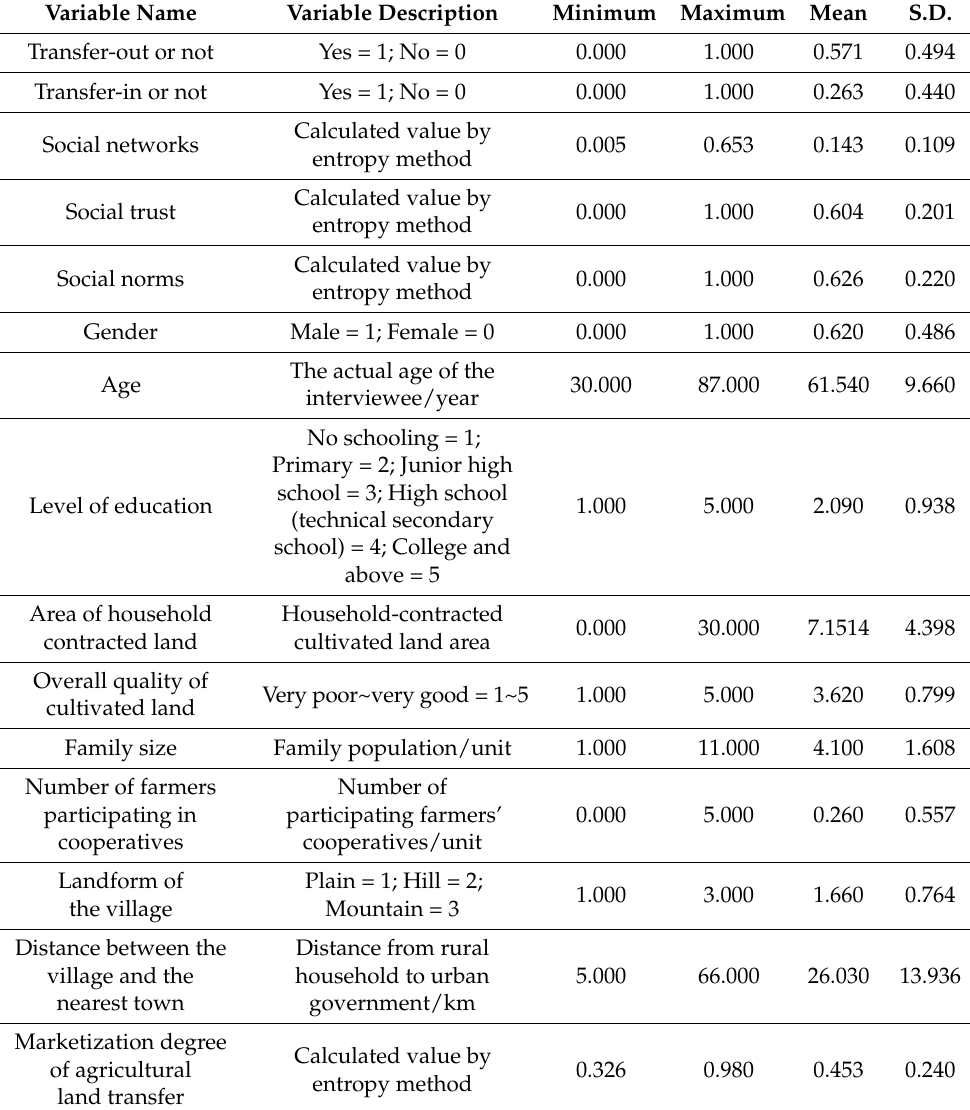
Table 2. Variable names and descriptive